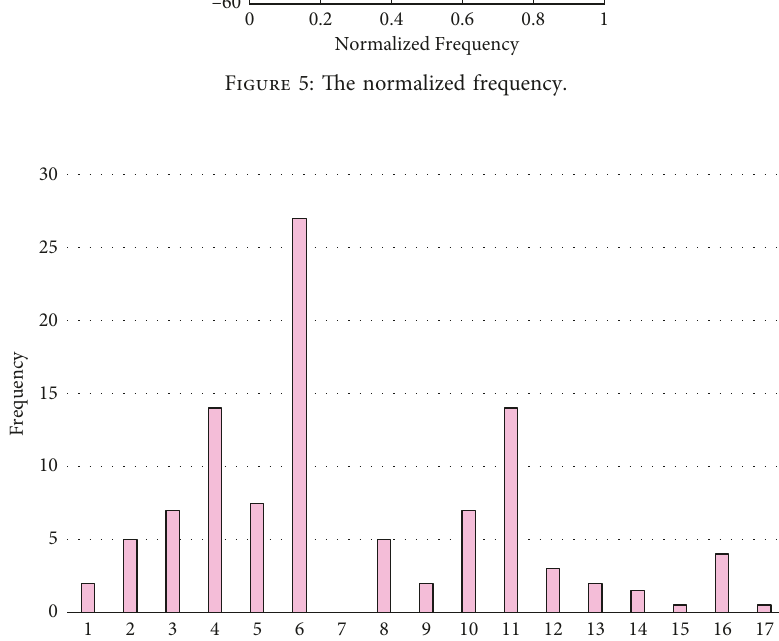
Figure 6: Proportion of classroom teaching behavior